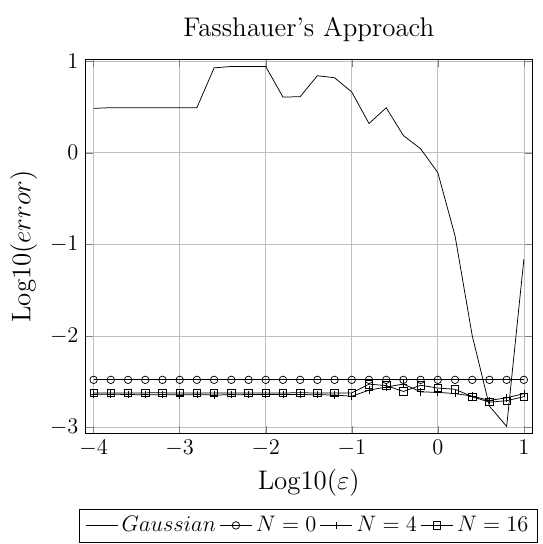
Figure 7. Comparison between Kansa’s and Fasshauer’s approaches for solving the advection partial differential equation at different ε values. The number of mesh points is fixed at 60 stretched points within the range [ −